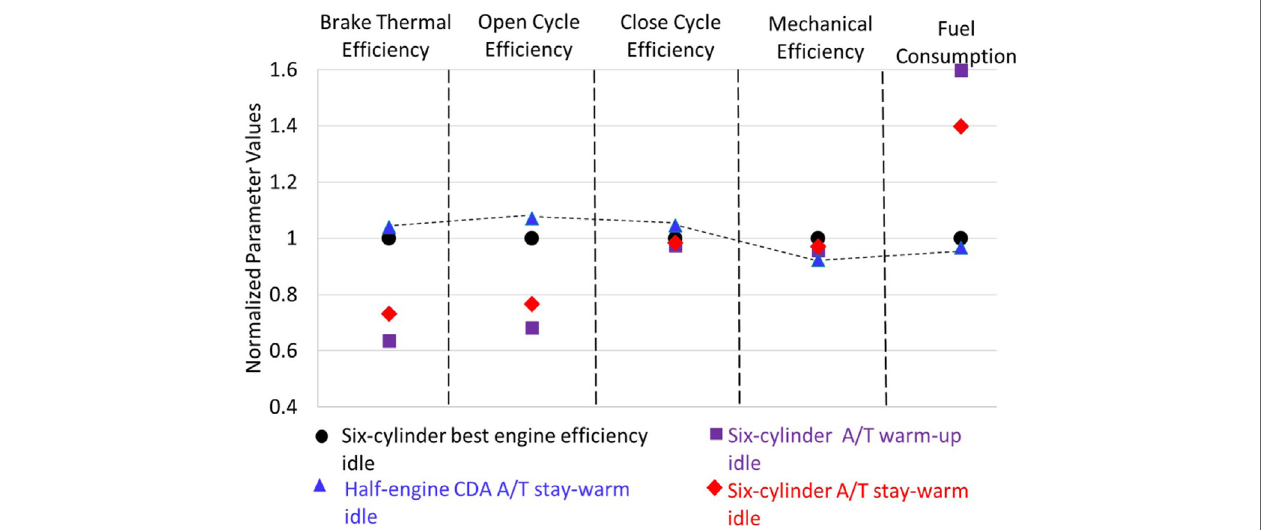
FigUre 10 | Experimental cycle efficiencies for the four strategies at 800 RPM/1.3 bar. The main driver for higher fuel consumption for the “Six-cylinder A/T warm-up idle” and “Six-cylinder A/T stay-warm idle” strategies is lower open cycle efficiency as a result of delayed fuel injection, and completely/mostly closed VGT positions. Fuel consumption for the “Half-engine CDA A/T stay-warm idle” strategy is lower than the “Six-cylinder best engine efficiency idle” strategy as a result of higher open cycle efficiency, which is higher due to lower pumping loss via less displaced volume during